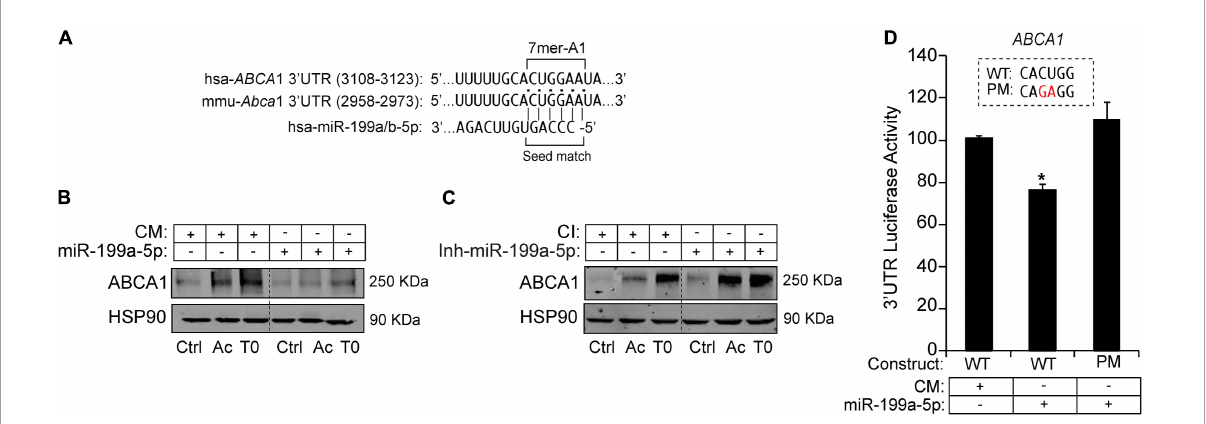
FIGURE6 MiR-199a-5p suppresses ABCA1 expression. (A) Human and mouse ABCA1 3 (cid:48) UTRs sequences containing target sites for miR-199a/b-5p. Highlighted in bold are the sequences for miR-199a/b-5p-binding site and seed match. (B,C) Representative Western blot analysis of ABCA1 in mouse peritoneal macrophages transfected with CM and miR-199a-5p or Ctrl-Inh or Inh-miR-199a-5p and stimulated with T090 3 µ M for 12 h and Ac-LDL for 24 h. HSP90 was used as a loading control. Dashed lines separates different transfection conditions within the same Western blot. Data are expressed as relative expression levels and correspond to the means ± SEM from three independent experiments performed in triplicate. * P < 0.05, significantly different from CM or CI without treatment. (D) Luciferase reporter activity in COS-7 cells transfected with CM or miR-199a-5p mimic and the ABCA1 3’UTR [wild type (WT)] or the constructs containing the indicated point mutations (PM). Nucleotides highlighted in red indicate the point mutations in the miR-199a-5p-binding sites. Data are expressed as relative luciferase activity compared to the activity in control samples cotransfected with an equal concentration of CM and correspond to the means ± SEM of three experiments performed in triplicate. * P < 0.05, significantly different from cells cotransfected with CM and the WT or PM